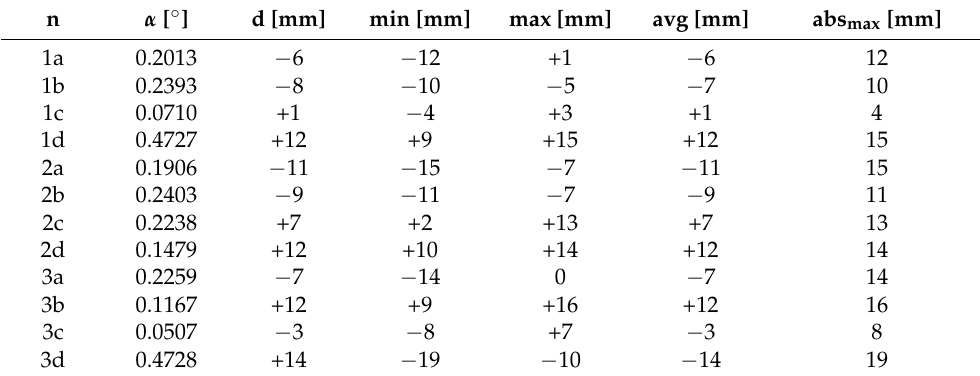
− 19 − 10 where n is the number of the selected column, α is the angular deviation between the direction of normal vectors, d is the distance between the surfaces calculated along the normal vector of the best-fit surfaces, min and max are minimal and maximal distances, avg is the average distance, abs max is the absolute maximal distance between the as-planned surface and the point cloud. The absolute maximal distance between the as-planned (BIM) surface and the segmented point cloud varies from 13 mm (wall no. 2) to 24 mm (wall no.4). The distance between the as-planned and as-built plane is a minimum − 7 mm (wall no. 2) and maximum +20 mm (wall no. 4). The positive values mean that the regression plane is in front of the as-planned plane in the direction of normal vectors (towards the inside of the room). The negative value means that the regression plane is behind the as-planned plane. The maximal difference between the orientation α of normal vectors is 0.0839 ◦ in the case of wall no. 2, representing a 3 mm deviation at 2 m. From the uncertainty of the position of measured points and the registration error, the standard deviation of the results was calculated using the uncertainty propagation law. Its value is 9 mm. Deviations (BIM vs. point cloud) under this value can be considered as not significant. The values in Tables 1 and 2 include the measurement uncertainty and the construction deviation (setting-out deviation and assembly deviation). The structural openings are plotted by black line into the deviation map (Figure 11). The deviations in the position of the openings within wall no.3 are 300 mm in the left-right direction and 200 mm in the top-bottom direction. The difference is approx. 100 mm on the top of the wall (under the ceiling) is due to the fact that the as-built surface was scanned. Although the detail of the model is LOD300, the insulation under the ceiling was not modeled. Just a small part of the concrete slab was scanned in the top right corner, where the insulation lamella was not assembled.